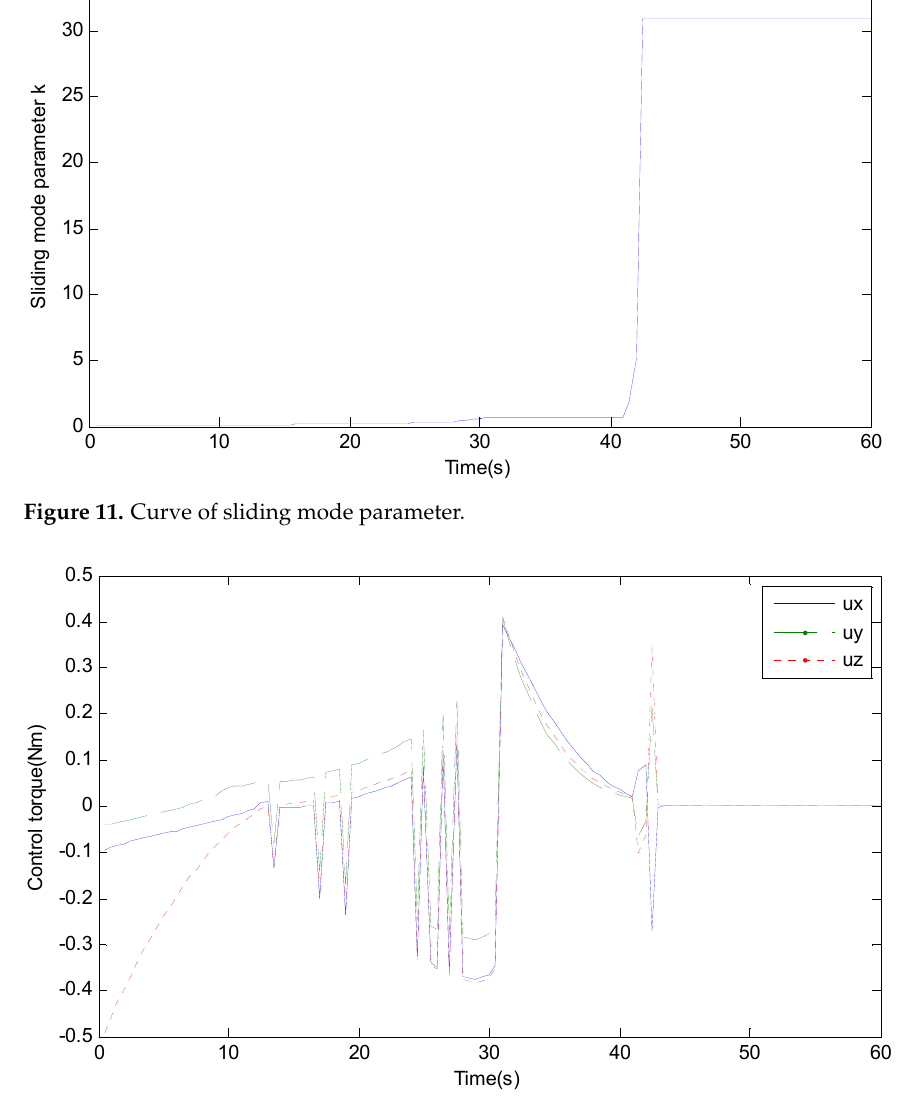
Figure 12. Curve of control torque.